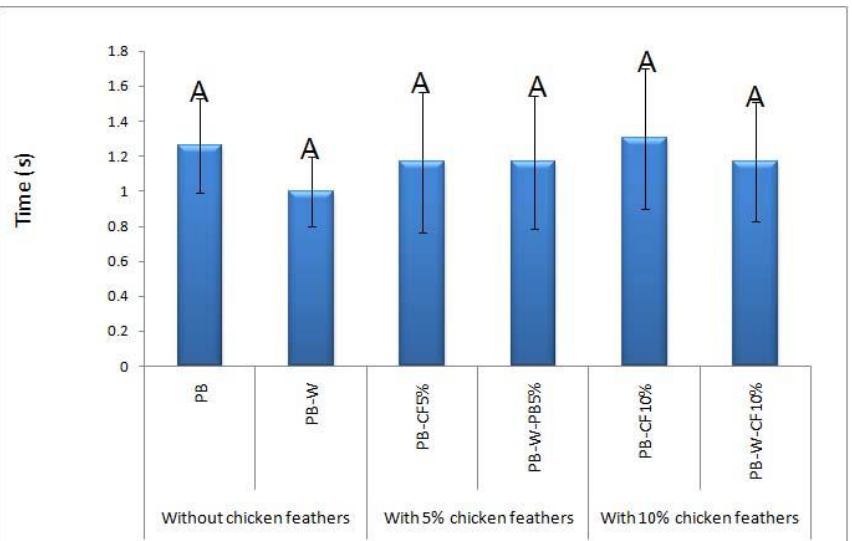
Figure 3. Duration of burning (in seconds) after the removal of piloted fire, in the six particleboard panels made from wood chips and the two chicken feather contents of 5% and 10%, containing 10% wollastonite (PB = particleboard panels; W = panels containing wollastonite; CF = chicken feather content) (letters on each column bar represent groupings based on Duncan’s multiple range test, α = 0.05).